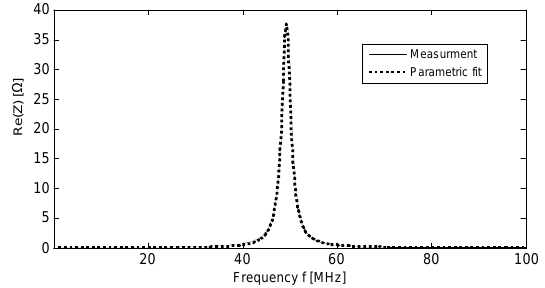
Figure 7. Measured impedance real part and analytical fit for a mi- cro coil with 33 turns and resonance frequency of 50.98MHz.